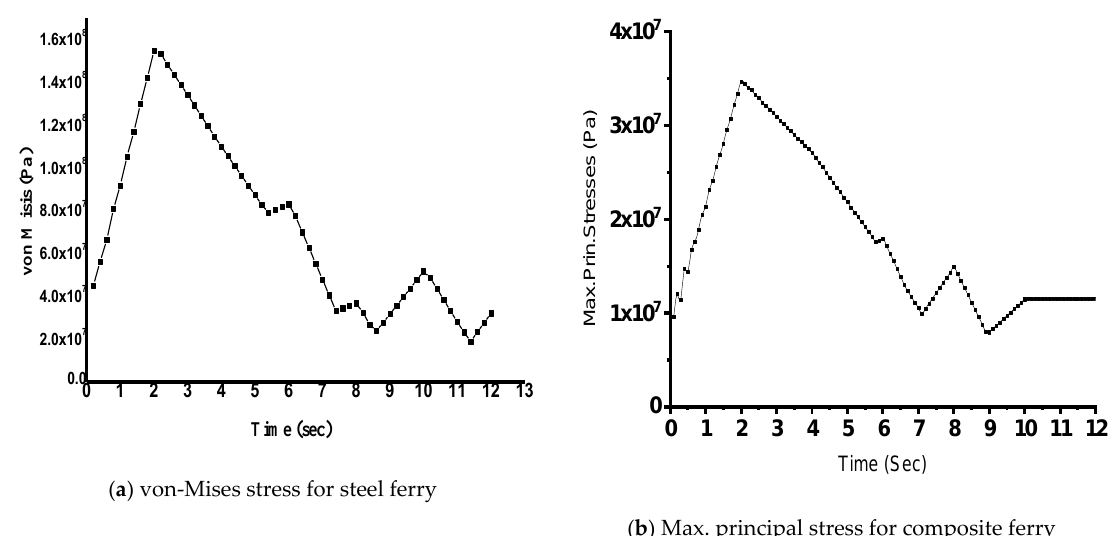
Figure 22. The change of stresses with time for case 1.